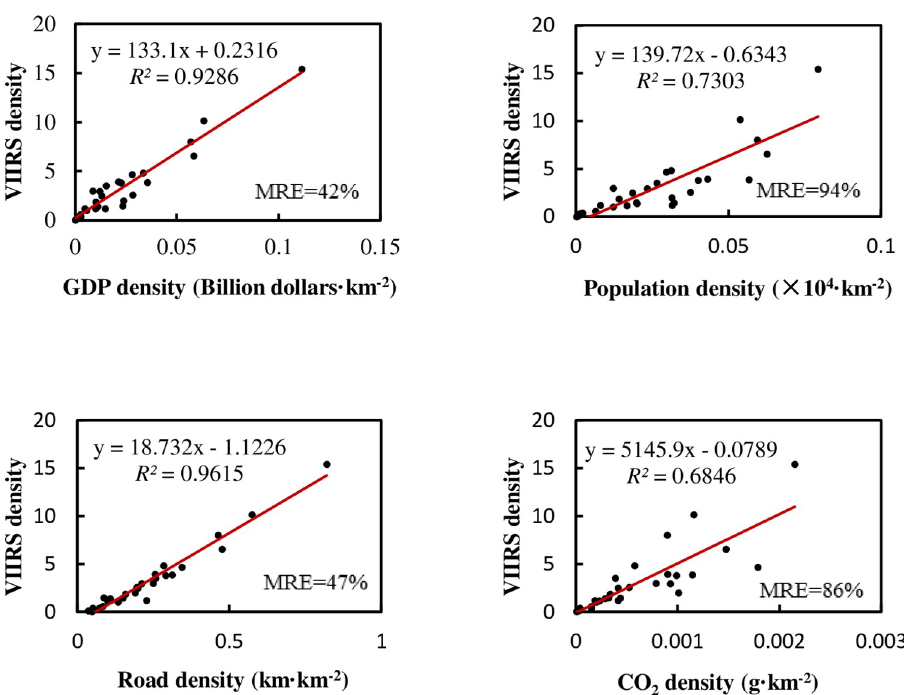
Fig 5. Relationship between NTL density and the density of various elements in provincial administrative regions of China after excluding three megacities.